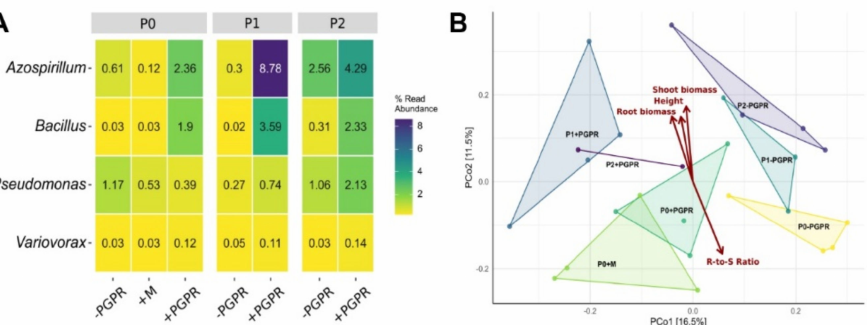
Figure 6. ( A ) Bacterial community composition at genus level detected in and on the root tissue of PGPR-inoculated and non-inoculated plants at P0, P1, and P2, and ( B ) their correlation with plant growth parameters. The correlation between bacterial community composition and plant growth was performed with principal coordinates analysis (PCoA) using Bray–Curtis distance units. The correlations are significant at p = 0.009, p = 0.003, p = 0.001, and p = 0.001 for plant height, root biomass, shoot biomass, and root-to-shoot ratio, respectively. The analysis was based on four biological replications ( n = 4), except for P2 + PGPR with n = 2 and P1-PGPR with n = 3 due to insufficient sample